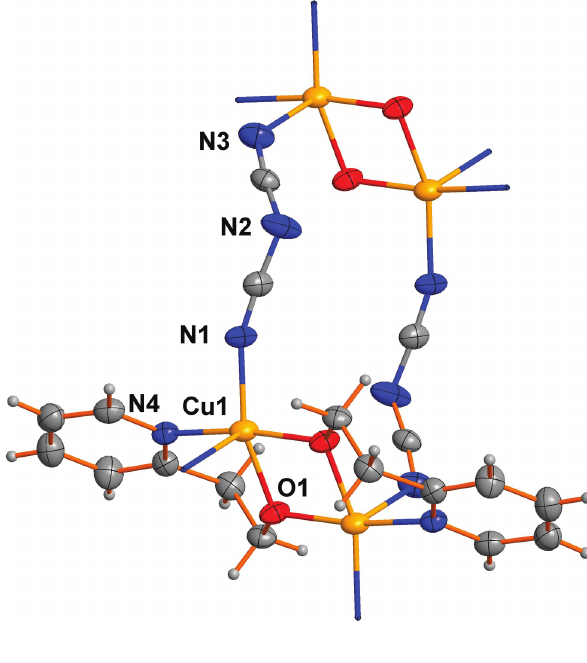
Table 1: Data collection and handling.